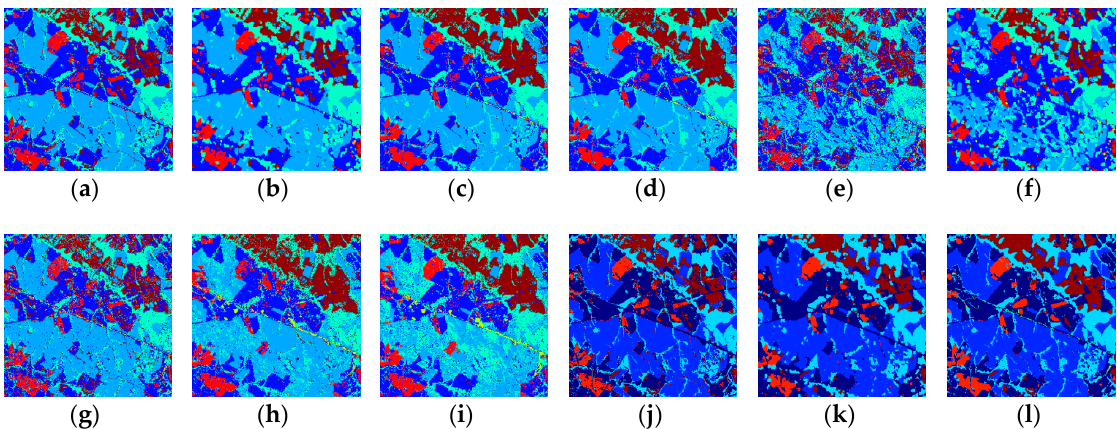
Figure 6. Classification results on the Landsat-5 image obtained by using the ( a ) k-NN, ( b ) k-NN-WH-MV, ( c ) k-NN-SRM, ( d ) k-NN-SRM-IC, ( e ) OPF, ( f ) OPF-WH-MV, ( g ) OPF-MRF, ( h ) OPF-SRM, ( i ) OPF-SRM-IC, ( j ) SVM, ( k ) SVM-WH-MV, ( l ) SVM-MRF.